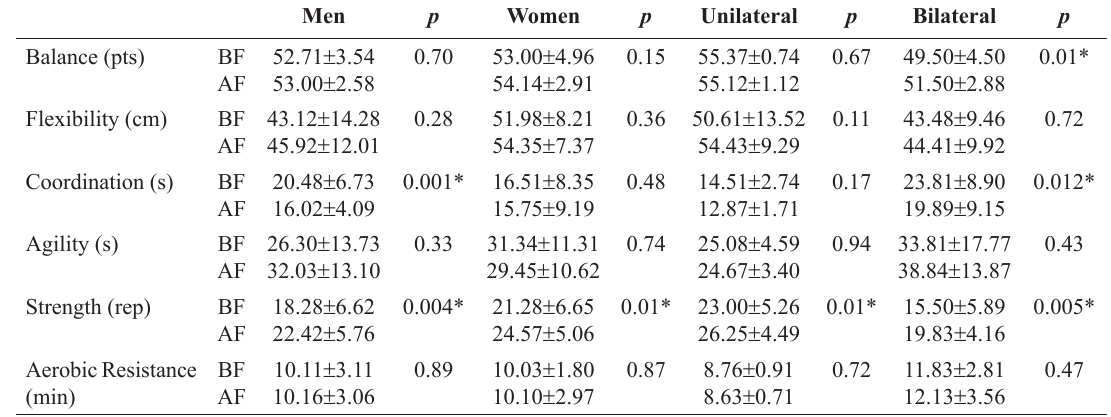
4. Mean, standard deviation, and p-values for the components of functional capacity according to gender and disease severity, before (BF) and after (AF) exercise